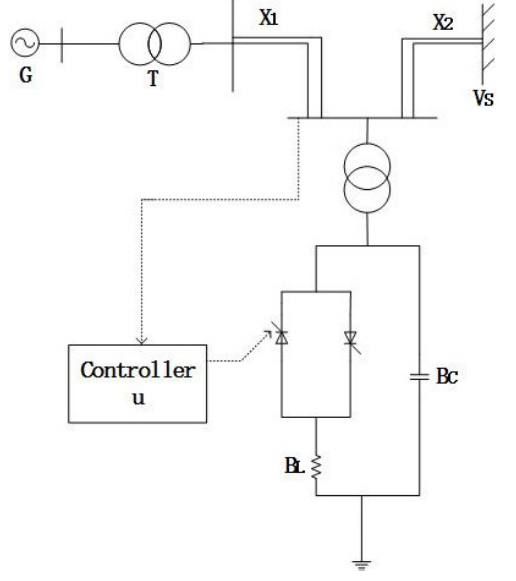
Figure 1. Single machine infinite bus system with